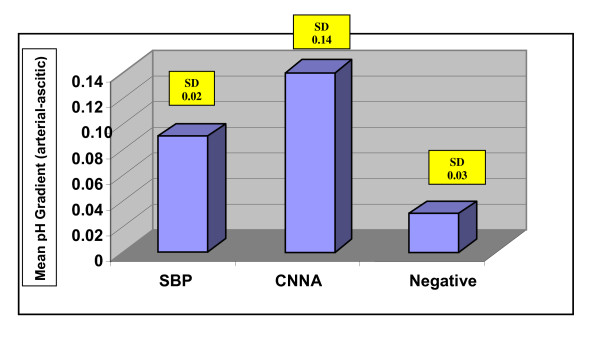
Histogram for the mean values (±SD) of pH gradient (Serum-asitic fluid) in different studied groups.